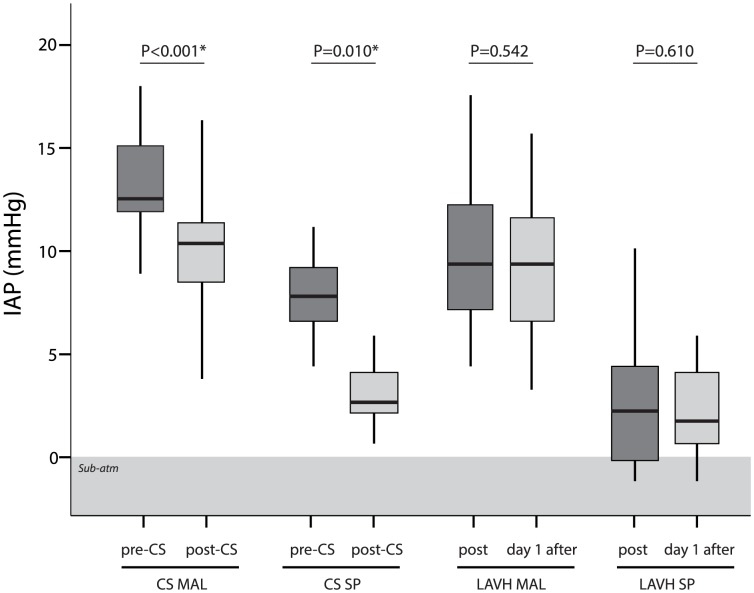
IAP before and after CS, and immediately after and day 1 after the LAVH.IAPMAL: IAP using the midaxillary line; IAPSP: IAP using the symphysis pubis; CS: caesarean section; LAVH: laparoscopic assisted vaginal hysterectomy.